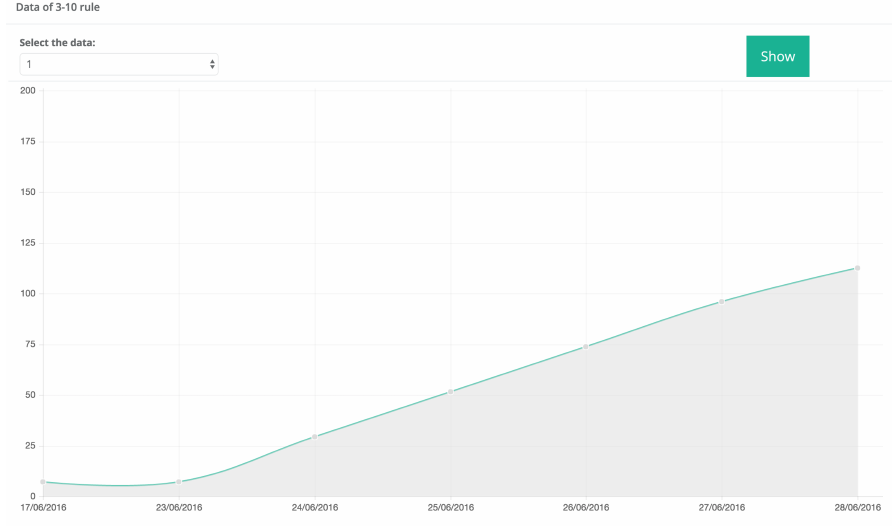
Figure 16. Evolution of the downy mildew development